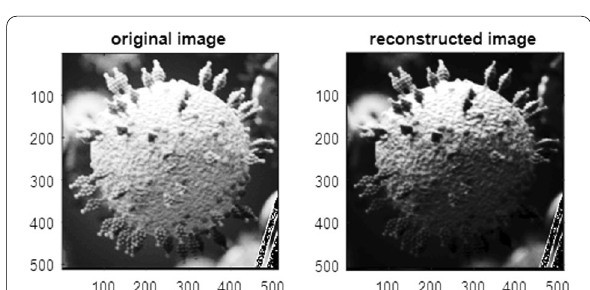
Fig. 9 In the left, the original image of corona virus is shown while in the right, the reconstructed image is obtained using confocal laser microscope provided with the apertures shown in